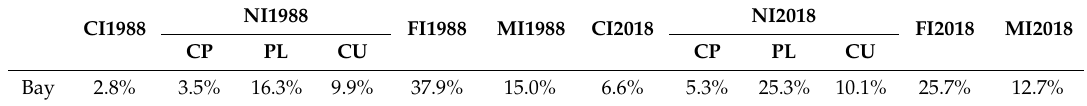
Table 4. Proportion of land use types of each country.